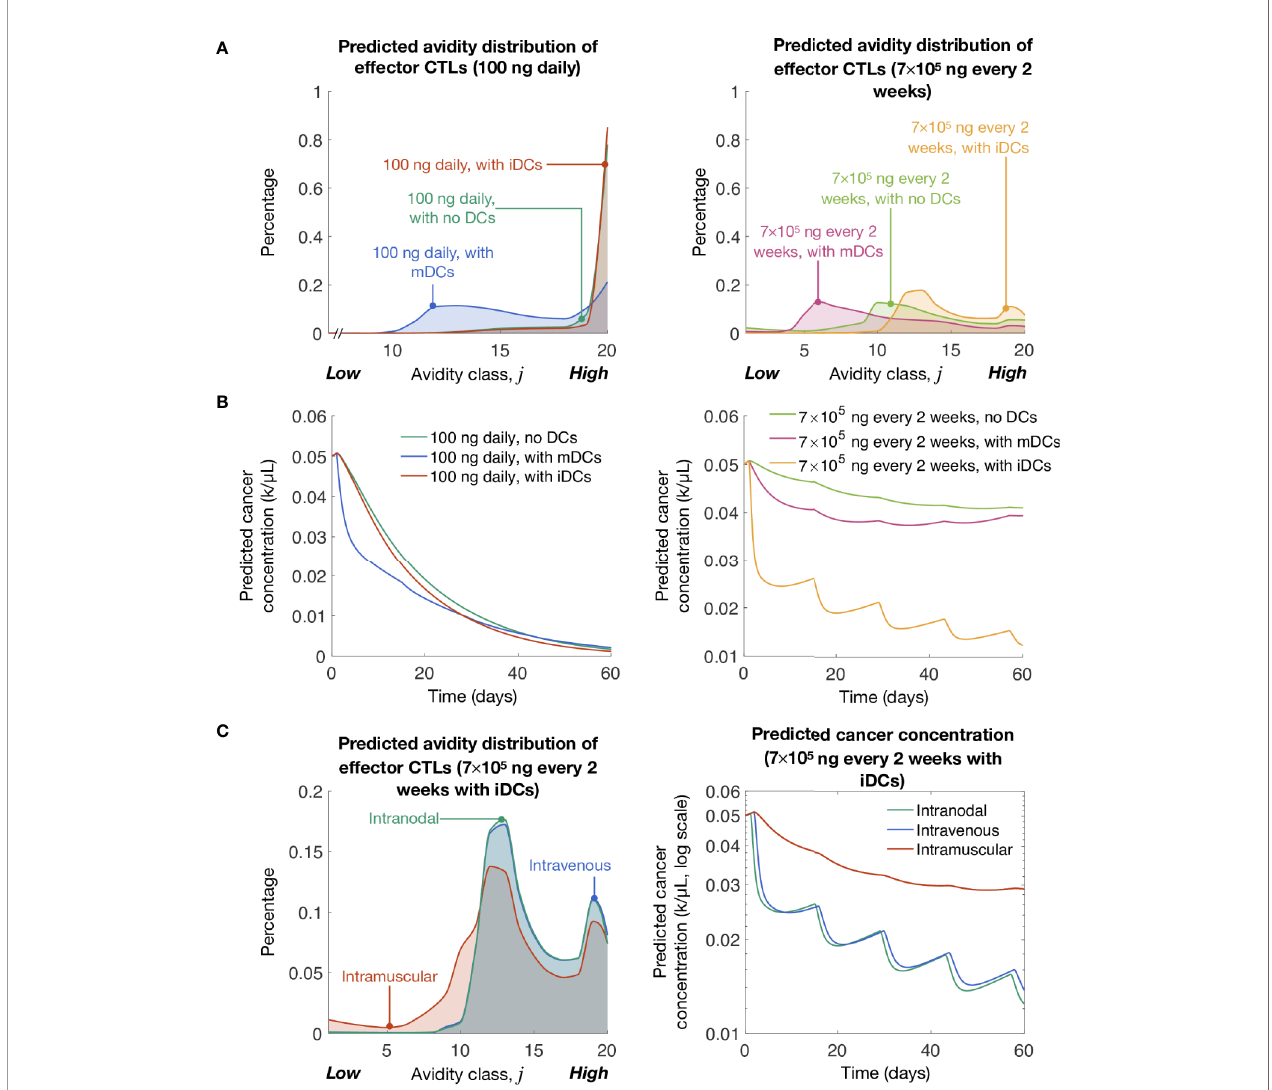
FIGURE 3 | Simulated induction of iDCs at clinically relevant vaccination doses yields signi fi cant tumor cell clearance. (A) Simulated avidity distribution of effector T cells for various vaccine protocols. (B) Simulated cancer concentrations over time for various vaccine protocols. (C) Simulated avidity distribution of effector T cells and tumor cell reduction (fold change) for different delivery routes. The unit ‘ k ’ denotes 10 3